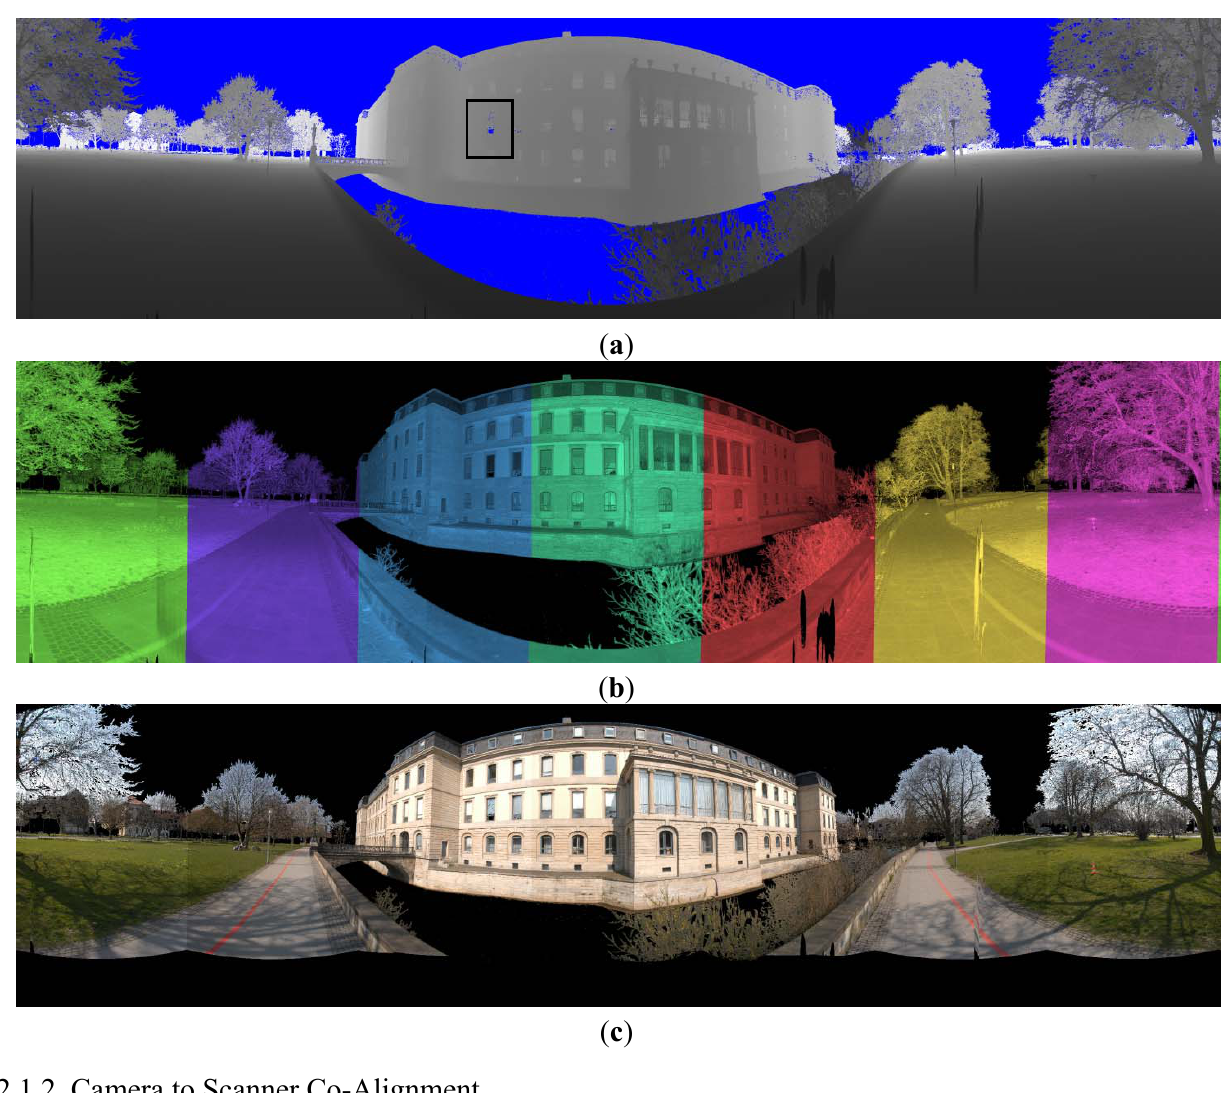
Figure 1. Polar representation of the color cue projected onto the range data. ( a ) The range data in polar representation (encircled is a no-reflectance area). ( b ) Selected region of the seven individual images for the construction the color channel. ( c ) Color content as projected to the scanner